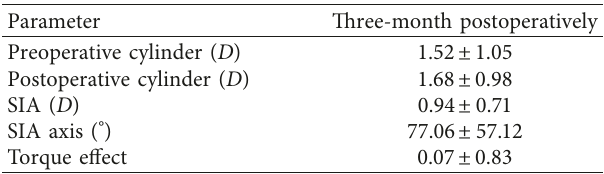
Table 4: The mean preoperative and postoperative cylinder, mean SIA, SIA axis, and torque effect 3 months postoperatively (vector analysis using the Alpins